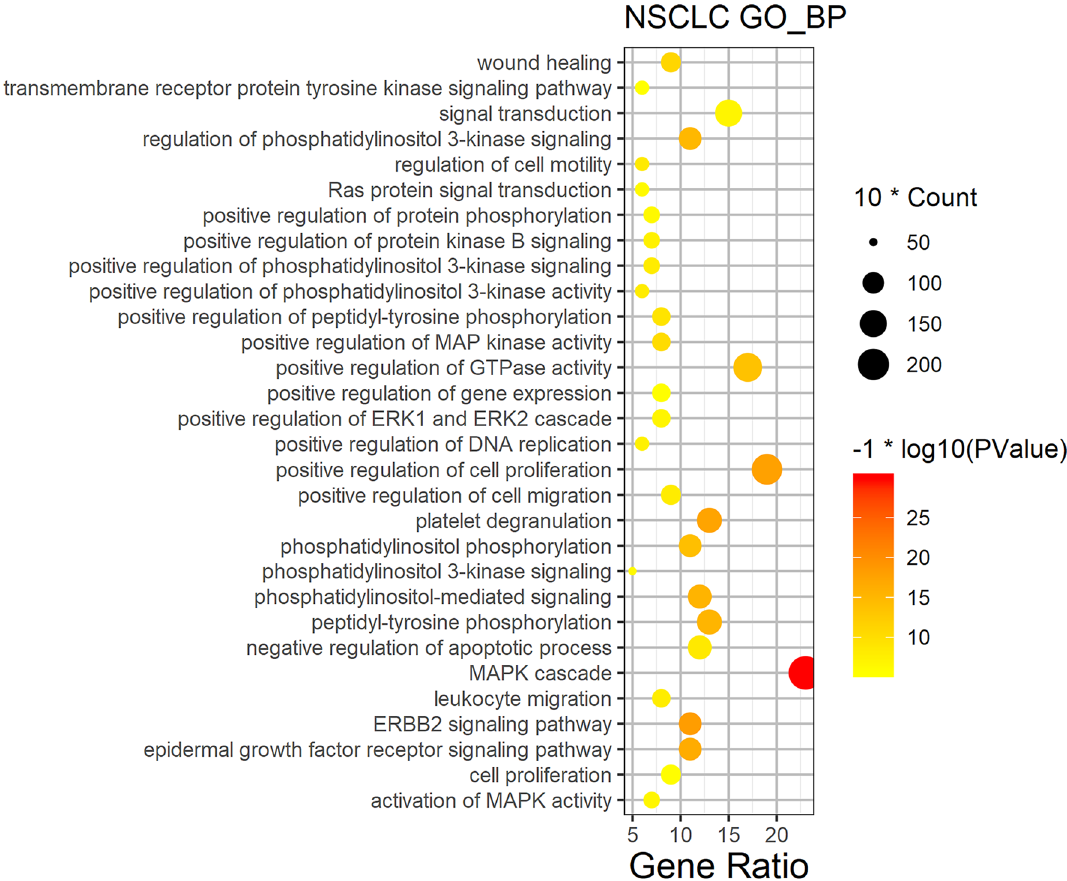
Figure 3. Biological process bubble diagram of cluster 1. (The color scales indicate different thresholds of adjusted p -value, and the sizes of the dots represent the gene count of each term.)